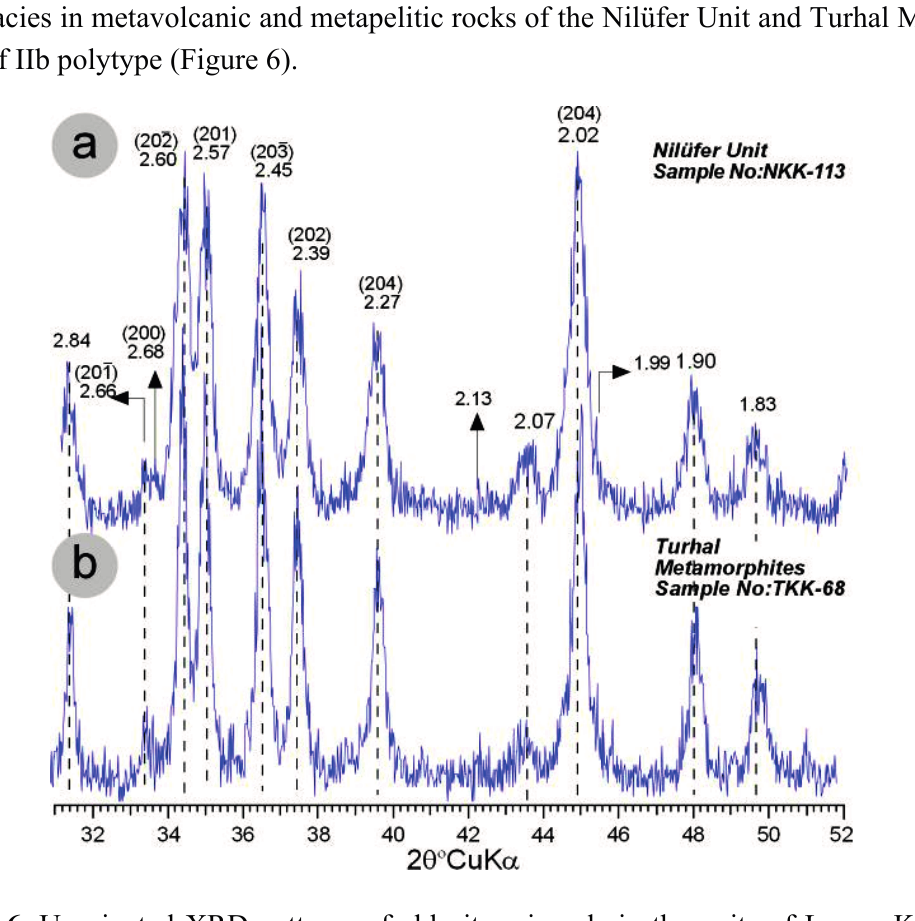
Figure 6. Unoriented XRD patterns of chlorite minerals in the units of Lower Karakaya Complex-Lower Part, ( a ) Slate sample of blueschist facies in the Nilüfer Unit; ( b ) Metagabbro sample of greenschist facies in the Turhal